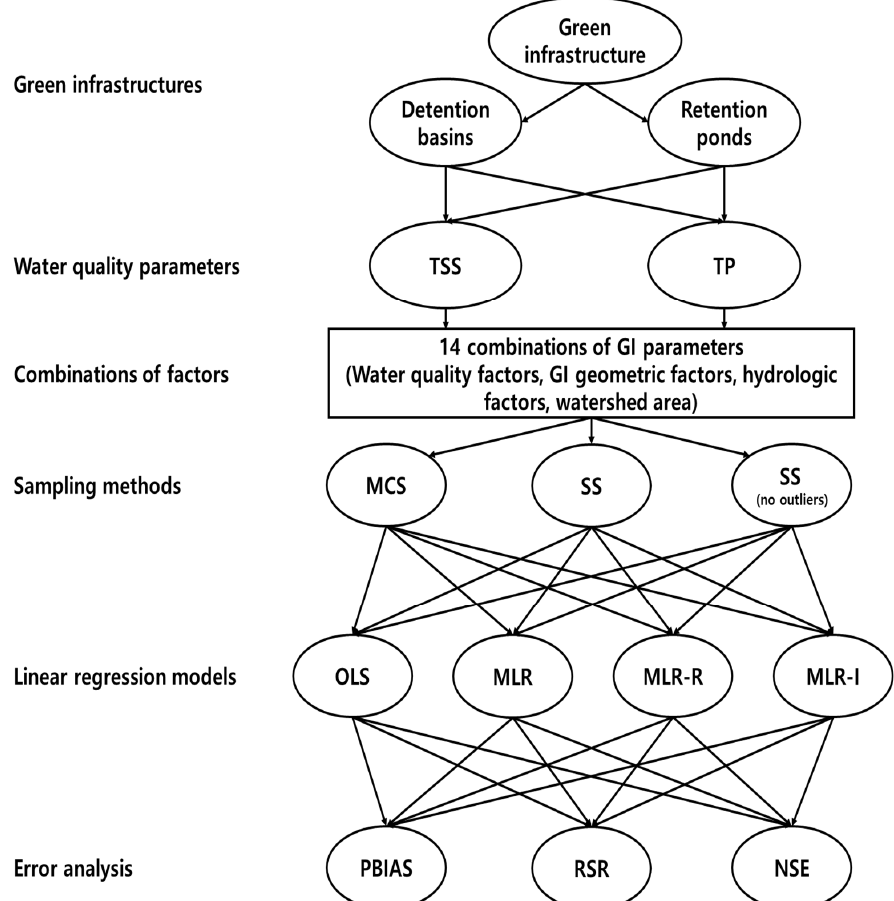
Figure 2. Schematic diagram of the methodology employed in this study. Int. J. Environ. Res. Public Health 2021 , 18 , x